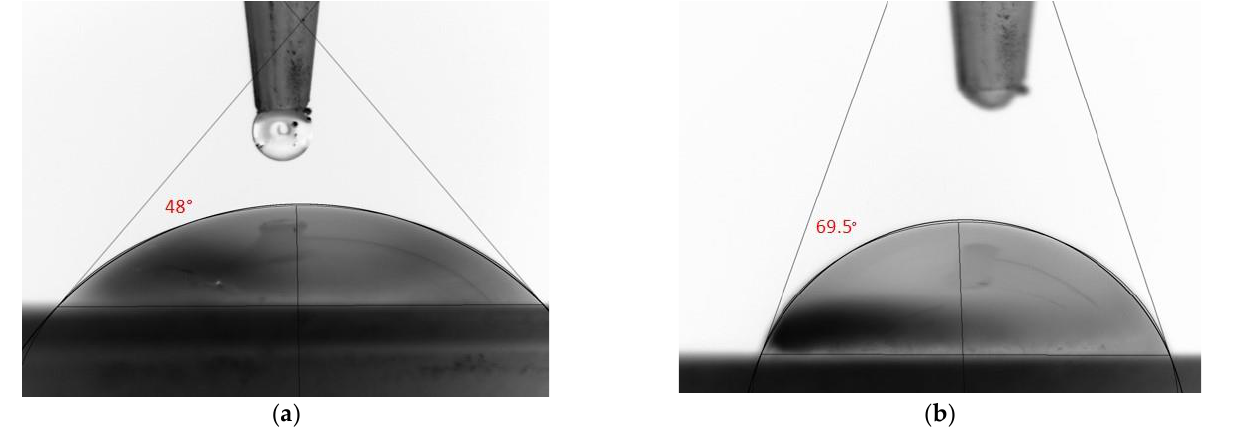
Figure 3. ( a ) Water contact angle of the control sample. ( b ) Water contact angle of the 5% ZnO sample.